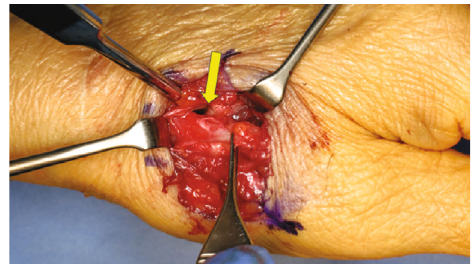
Figure 5: Macroscopic fi ndings at the time of the second surgery. EPL tendon rerupture is shown to have occurred in the dead space where the scaphoid bone was previously